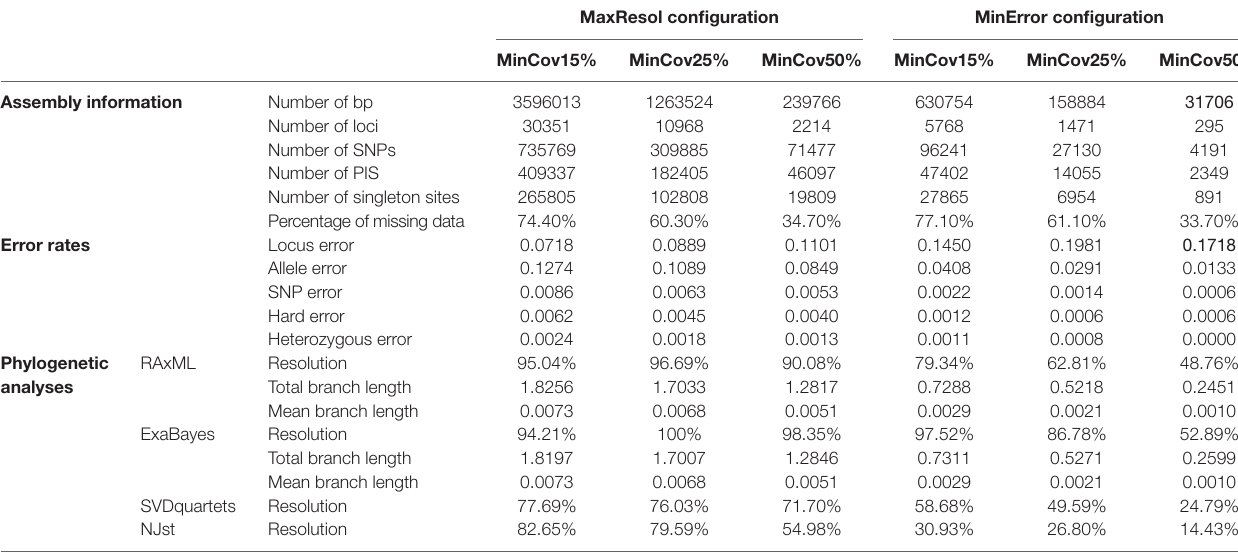
TaBlE 2 | Characteristics of assembled genotyping-by-sequencing datasets from the final PyRAD